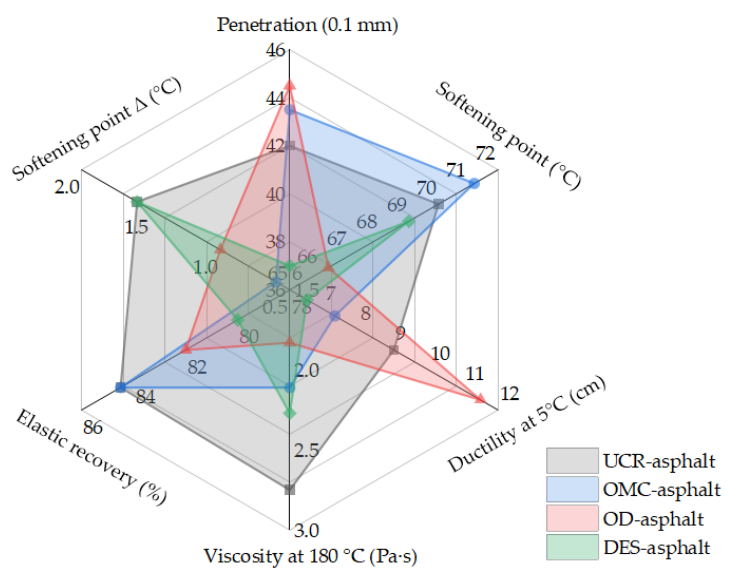
Figure 13. Radar chart for the chemical adjuvants based on the physical properties of the asphalt binder containing the activated crumb rubber powder prepared by the mechanochemical treatment method.